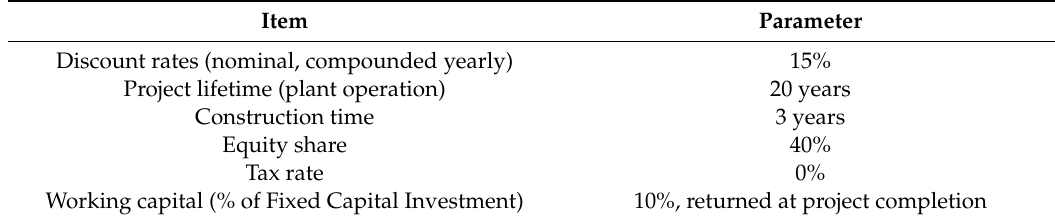
Table 1. Parameters for discounted cash flow